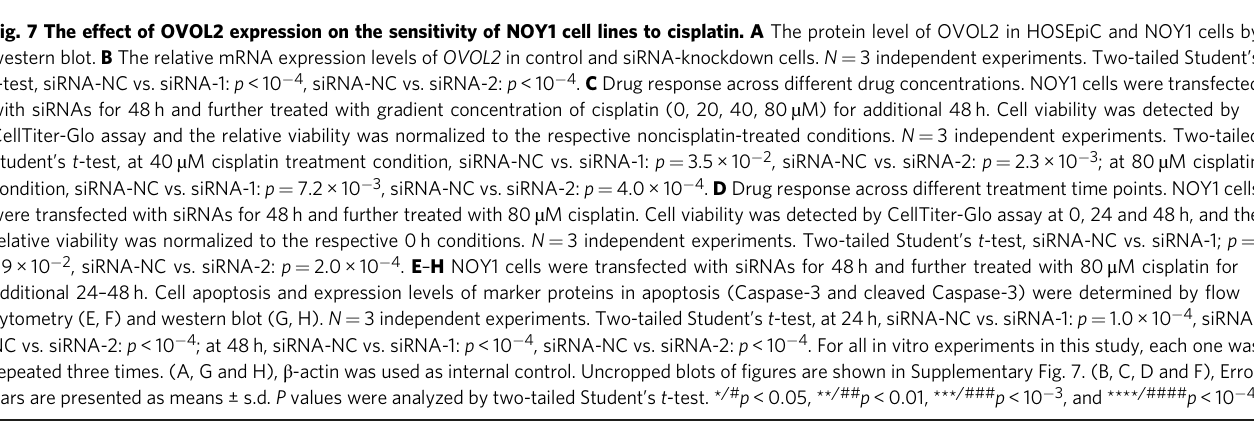
Fig. 7 The effect of OVOL2 expression on the sensitivity of NOY1 cell lines to cisplatin. A The protein level of OVOL2 in HOSEpiC and NOY1 cells by western blot. B The relative mRNA expression levels of OVOL2 in control and siRNA-knockdown cells. N = 3 independent experiments. Two-tailed Student ’ s t -test, siRNA-NC vs. siRNA-1: p <10 − 4 , siRNA-NC vs. siRNA-2: p < 10 − 4 . C Drug response across different drug concentrations. NOY1 cells were transfected with siRNAs for 48h and further treated with gradient concentration of cisplatin (0, 20, 40, 80 µ M) for additional 48h. Cell viability was detected by CellTiter-Glo assay and the relative viability was normalized to the respective noncisplatin-treated conditions. N = 3 independent experiments. Two-tailed Student ’ s t -test, at 40 µ M cisplatin treatment condition, siRNA-NC vs. siRNA-1: p = 3.5× 10 − 2 , siRNA-NC vs. siRNA-2: p = 2.3 × 10 − 3 ; at 80 µ M cisplatin condition, siRNA-NC vs. siRNA-1: p = 7.2× 10 − 3 , siRNA-NC vs. siRNA-2: p = 4.0× 10 − 4 . D Drug response across different treatment time points. NOY1 cells were transfected with siRNAs for 48h and further treated with 80 µ M cisplatin. Cell viability was detected by CellTiter-Glo assay at 0, 24 and 48h, and the relative viability was normalized to the respective 0 h conditions. N = 3 independent experiments. Two-tailed Student ’ s t -test, siRNA-NC vs. siRNA-1; p = 1.9× 10 − 2 , siRNA-NC vs. siRNA-2: p = 2.0× 10 − 4 . E – H NOY1 cells were transfected with siRNAs for 48h and further treated with 80 μ M cisplatin for additional 24 – 48h. Cell apoptosis and expression levels of marker proteins in apoptosis (Caspase-3 and cleaved Caspase-3) were determined by fl ow cytometry (E, F) and western blot (G, H). N = 3 independent experiments. Two-tailed Student ’ s t -test, at 24h, siRNA-NC vs. siRNA-1: p = 1.0× 10 − 4 , siRNA- NC vs. siRNA-2: p <10 − 4 ; at 48h, siRNA-NC vs. siRNA-1: p < 10 − 4 , siRNA-NC vs. siRNA-2: p < 10 − 4 . For all in vitro experiments in this study, each one was repeated three times. (A, G and H), β -actin was used as internal control. Uncropped blots of fi gures are shown in Supplementary Fig. 7. (B, C, D and F), Error bars are presented as means ± s.d. P values were analyzed by two-tailed Student ’ s t -test. * /# p < 0.05, ** /## p < 0.01, *** /### p < 10 − 3 , and **** /#### p < 10 −